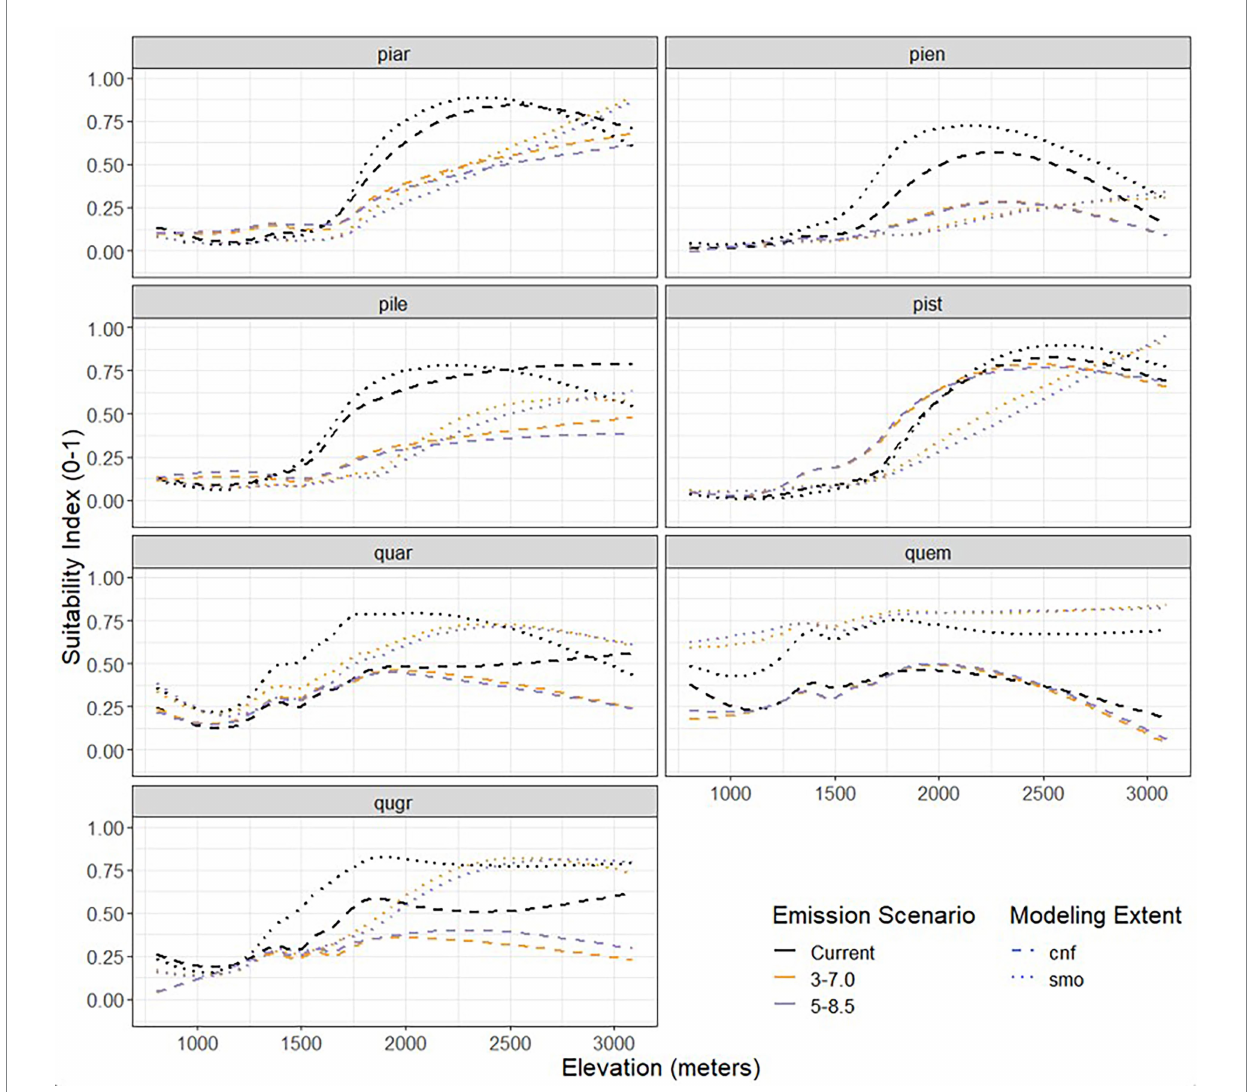
FIGURE 7 Comparison of the smoothed relationship between mean habitat suitability and elevation for the seven tree species of interest in the Coronado National Forest for current conditions (black, solid) and 2,100 estimates (colored, dashed) under different emissions